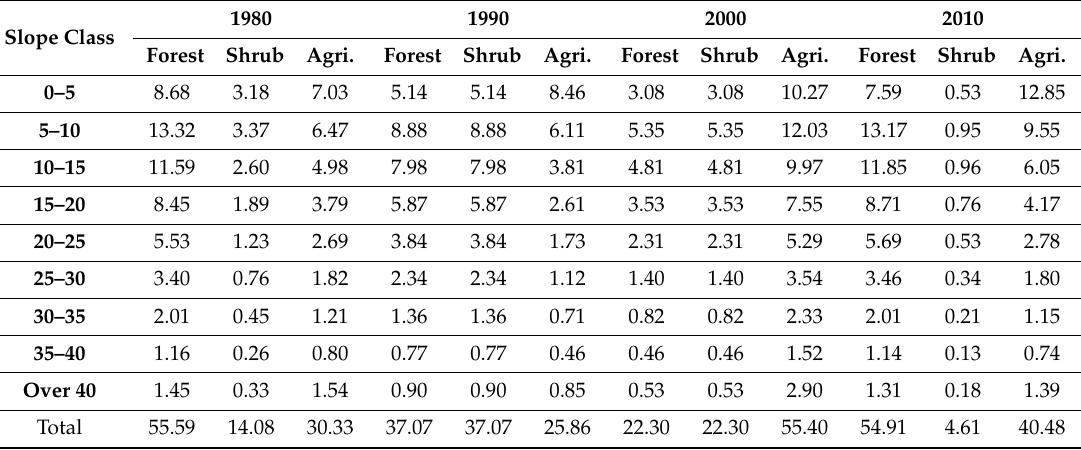
Figure 11. Nepal: forest, shrubland, and agricultural areas of Nepal by 9 elevation classes for 1980, 1990, 2000, and 2010. Table 6. Nepal: land use as a percentage of total area of forest, shrubland, and agriculture for 1980, 1990. 2000 and 2010. ((Individual land-use area for a slope class / (sum of forest + shrubland + agriculture) * 100).